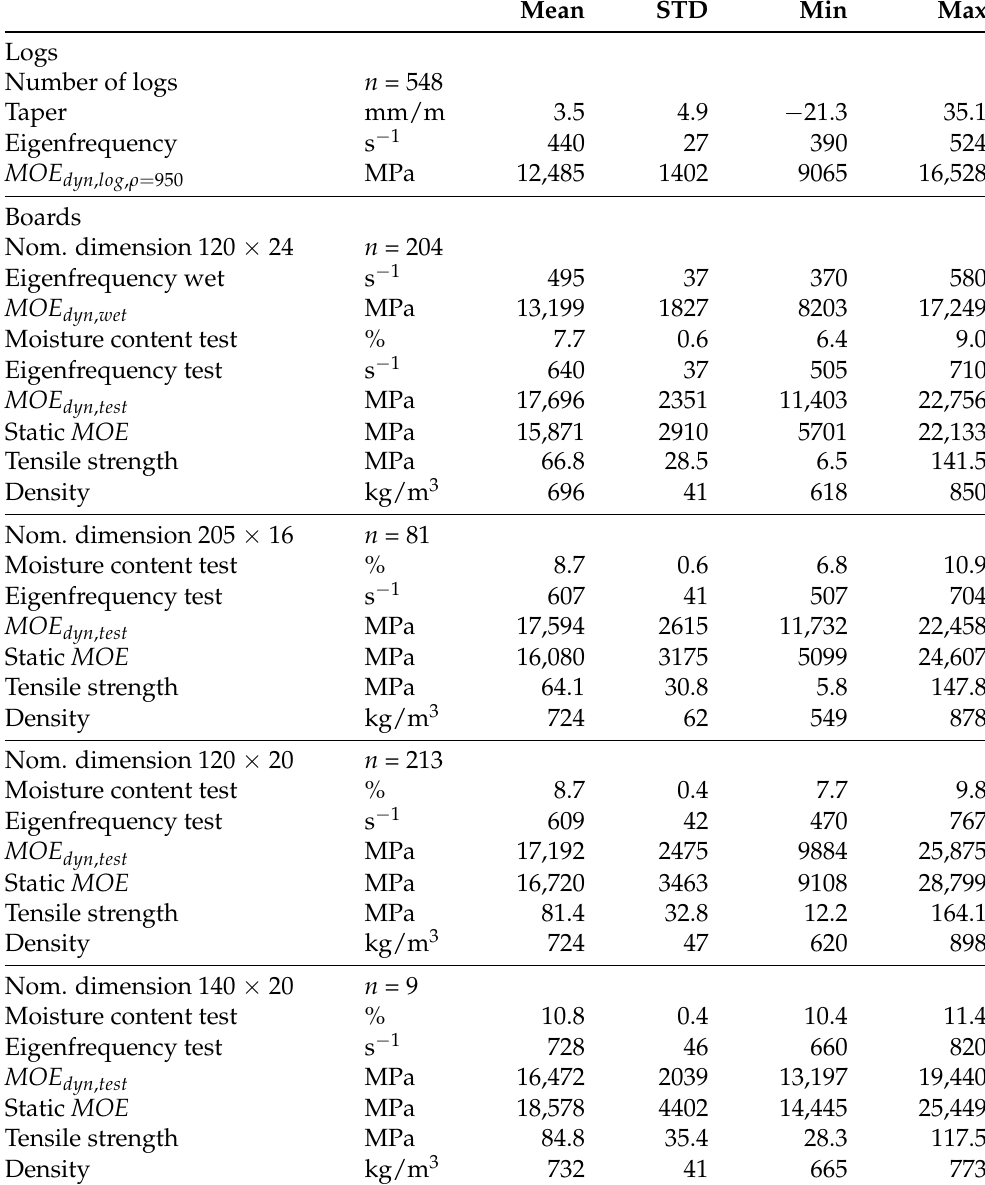
Table 2. Results of logs and boards.